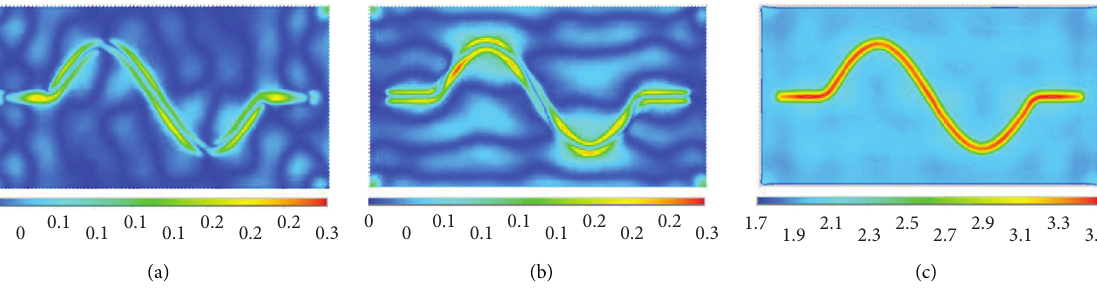
Figure 40: P wave incident ( C